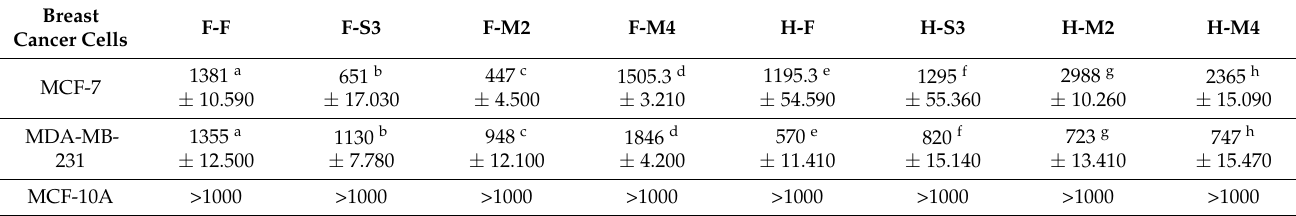
Means with the different letters (a–h) are significantly different in a row at a 95% confidence interval.